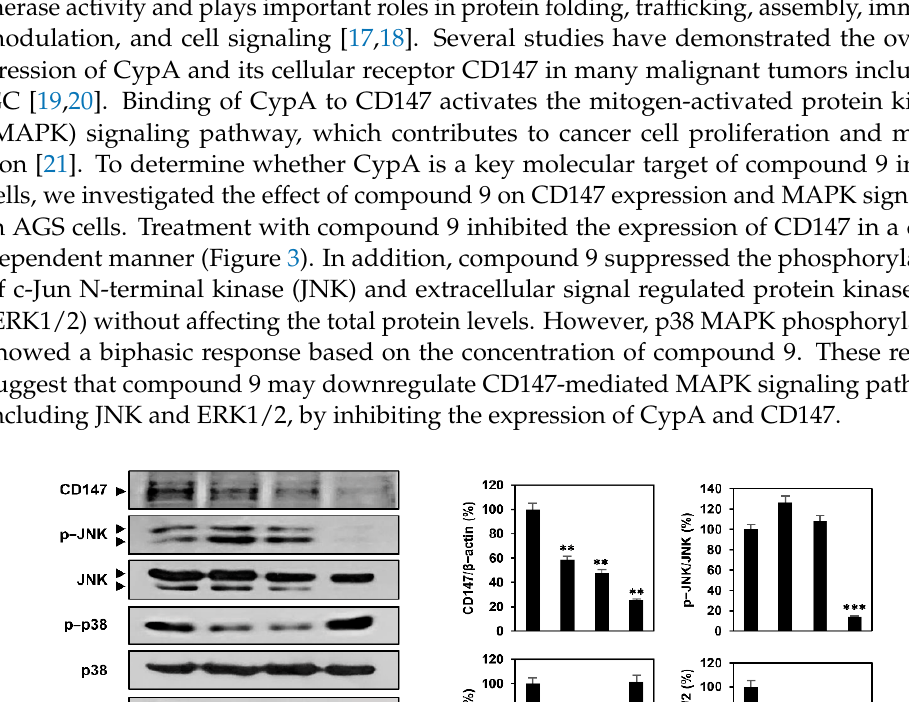
Figure 2. Validation of the identified protein spots. AGS cells were treated with compound 9 (100– 400 μ M) for 24 h. Protein levels were detected by western blot analysis and further quantified by densitometry. The level of β -actin was used as an internal control. ** p < 0.01, *** p < 0.001 vs. the control.